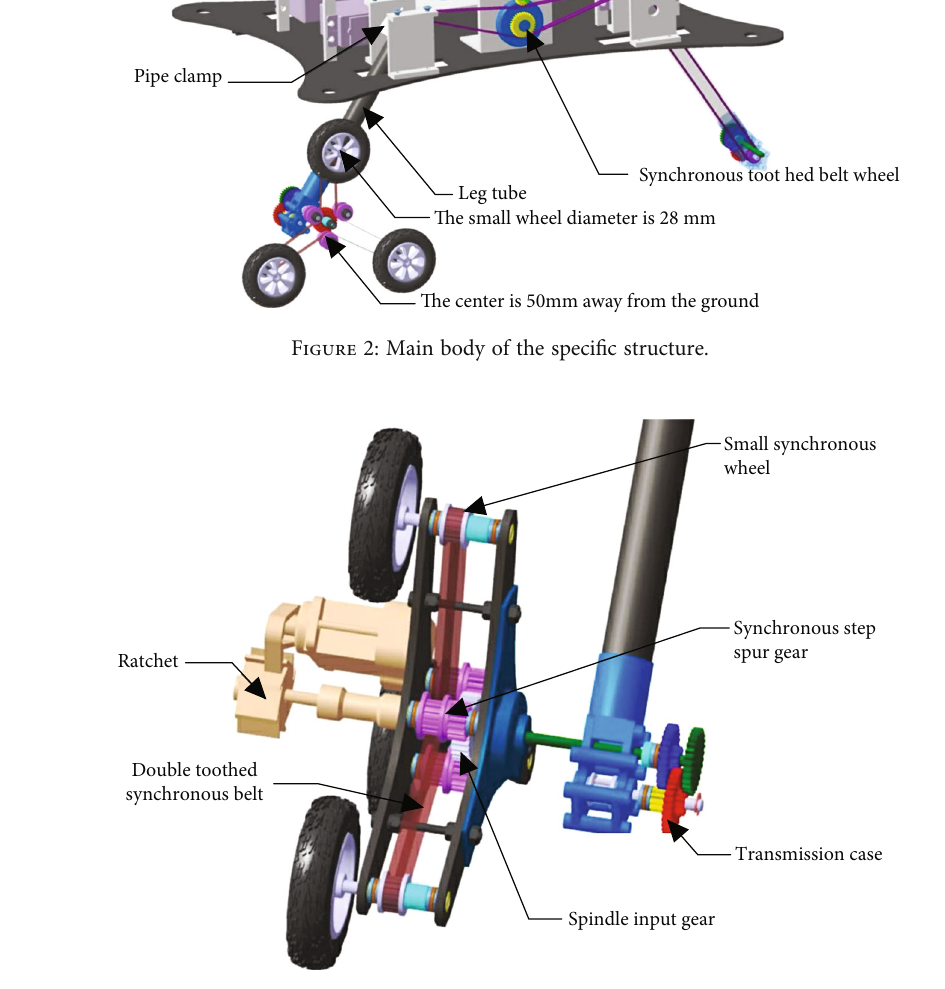
Figure 3: Speci fi c structure of the planetary wheel. Table 1: Brushless DC motor